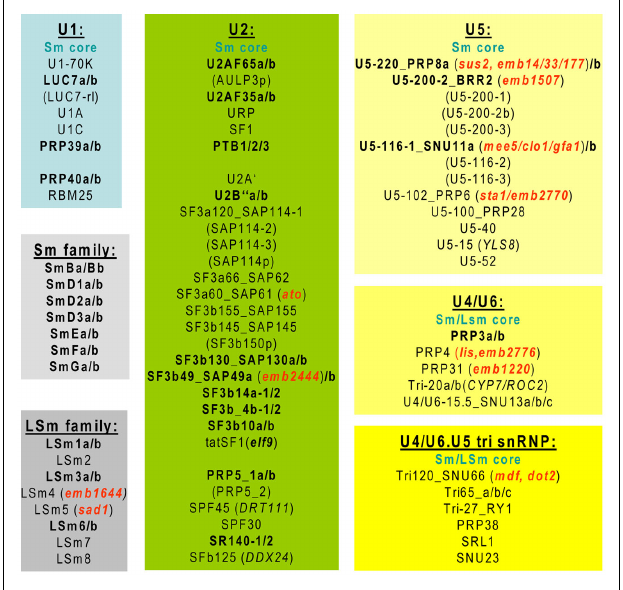
FIGURE 1 | Spliceosomal U snRNP components conserved in Arabidopsis . Subunits encoded by two or more genes are highlighted in bold and characterized gene mutations are indicated in